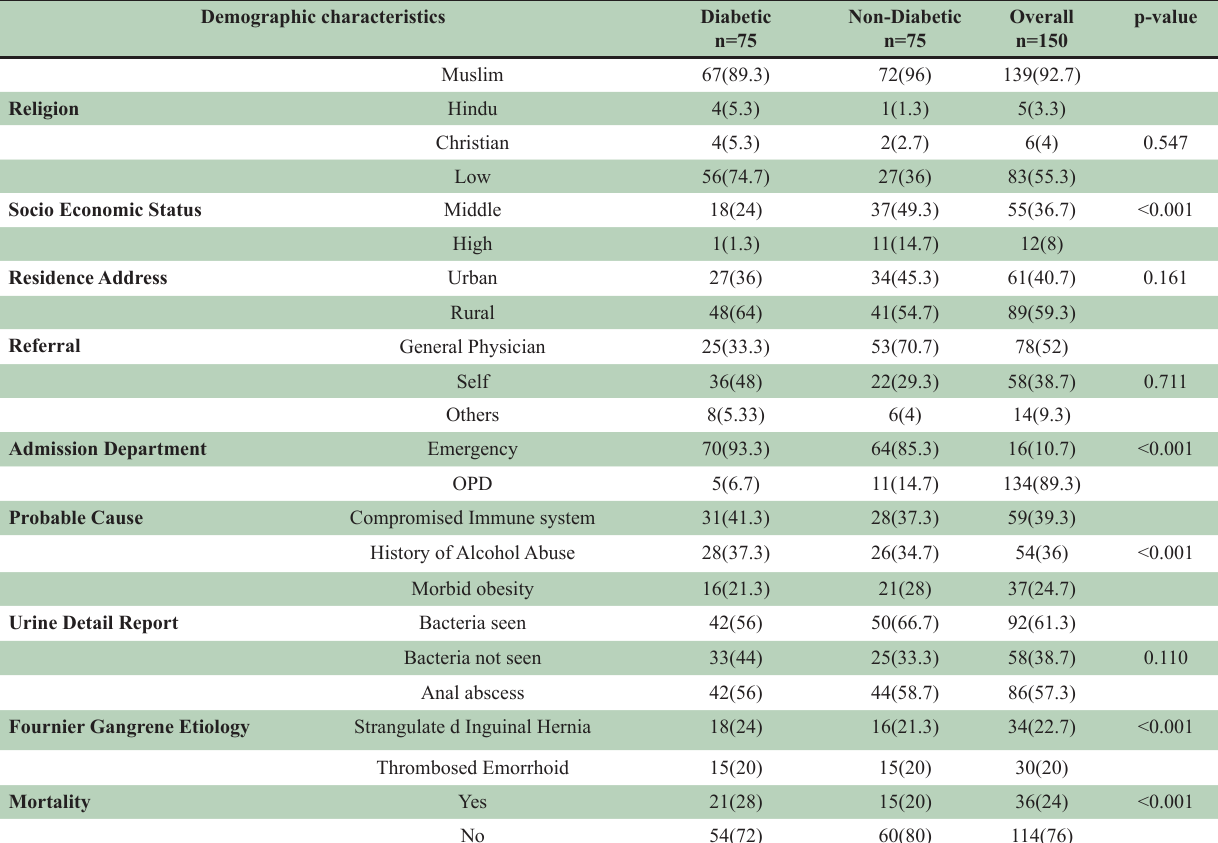
Table-II: Demographic characteristics of the study population.